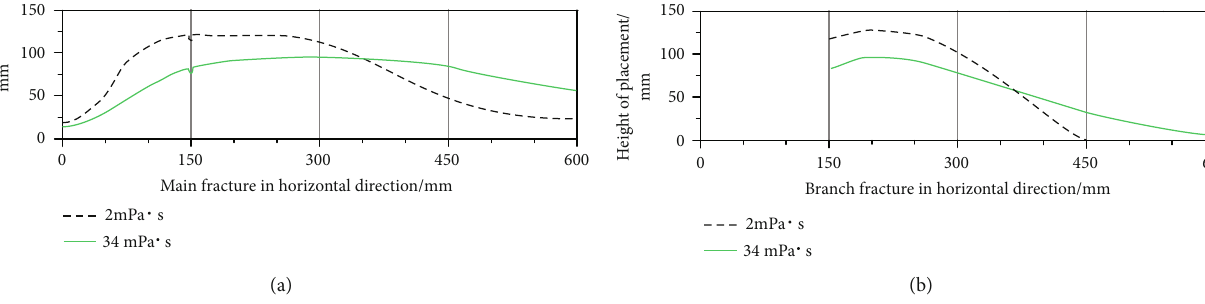
Figure 13: Proppant transport characteristics in the main fracture (a) and branch fractures (b) with di ff erent fracturing fl uid